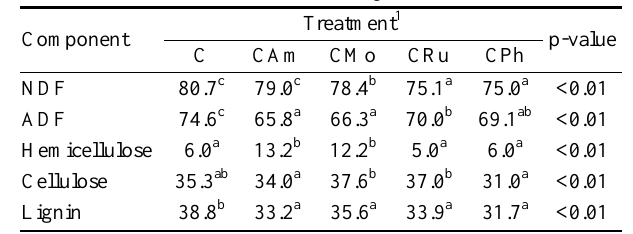
Table 2. Influence of various chemical and biological treatments on Van Soest’s fiber fractions of cocoa pod